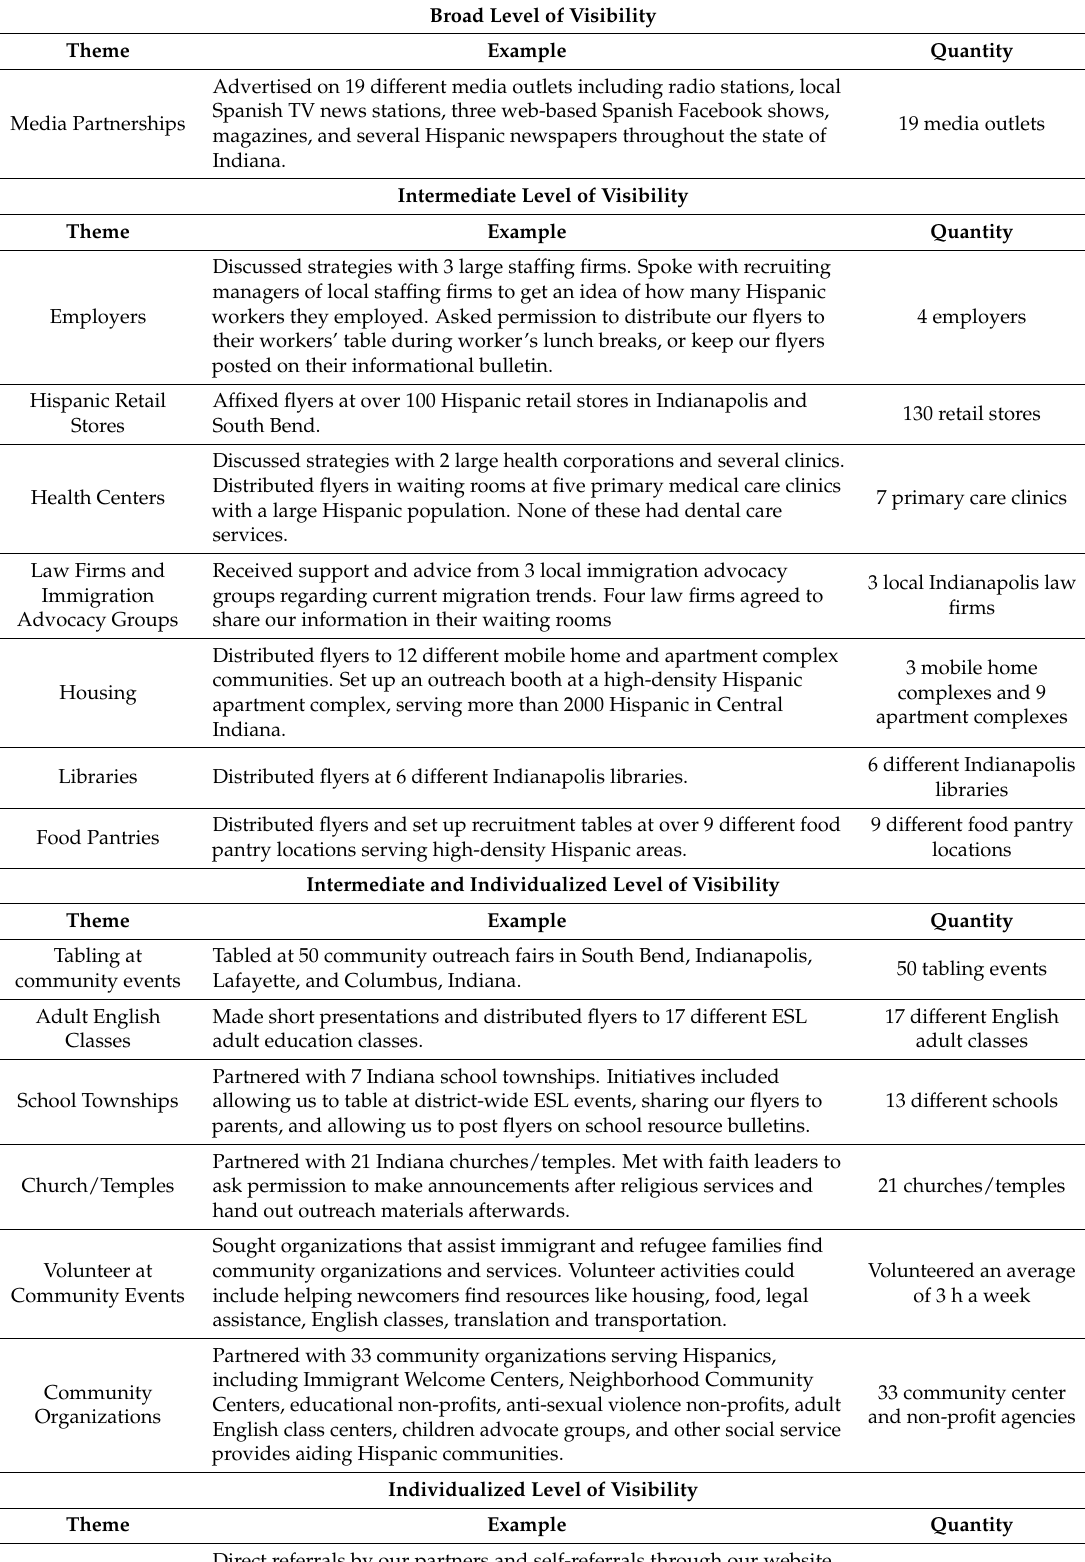
Table 1. Levels of Visibility and Components for VidaSana